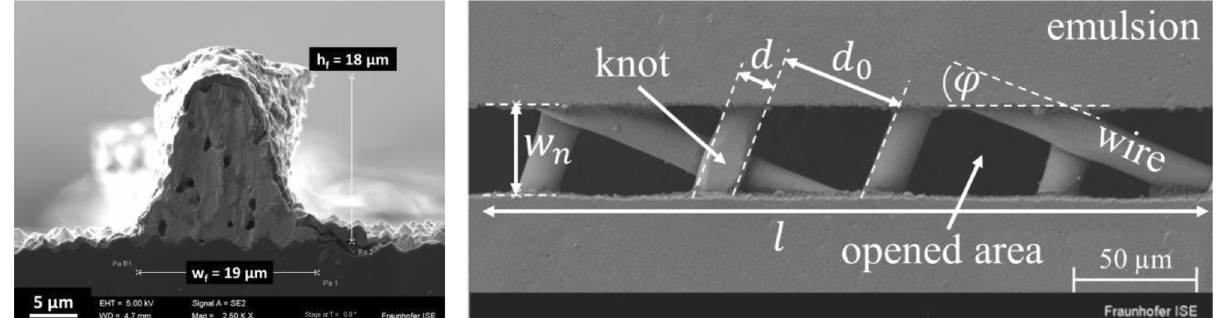
Figure 1. On the left, a fine line Ag-electrode (finger) for Si-solar cell metallization is shown 16 . On the right, we present a SEM image of a screen opening channel, defined by the nominal screen opening width w n , the channel length l , the wire diameter d , the mesh opening d 0 and the angle between emulsion edge and mesh wires ϕ .